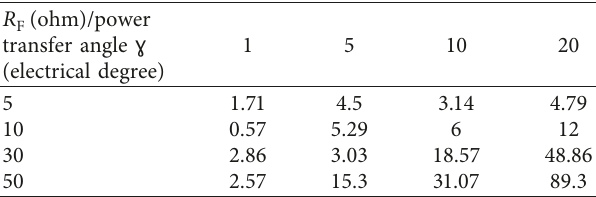
Table 10: Method error in the case of the power line with a du- plicate